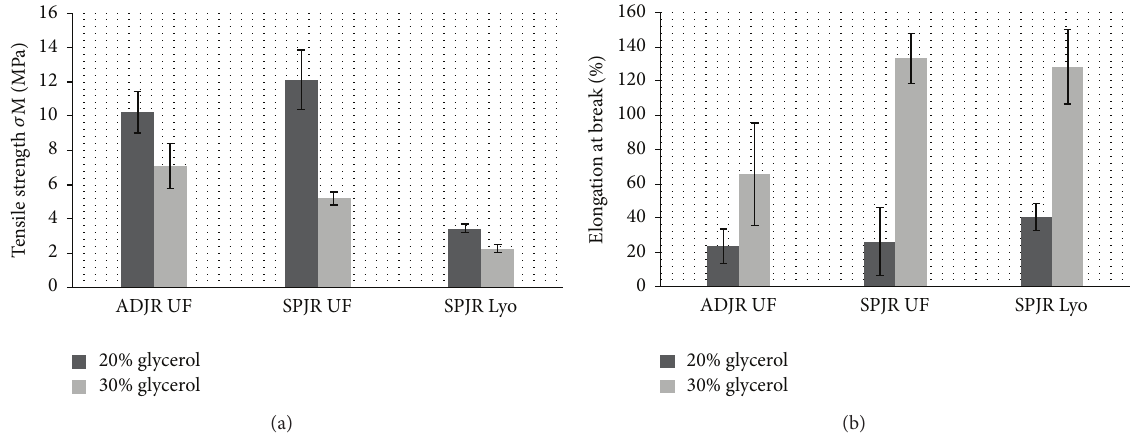
Figure 3: Tensile strength (a) and elongation at break (b) of Jatropha -based cast films.